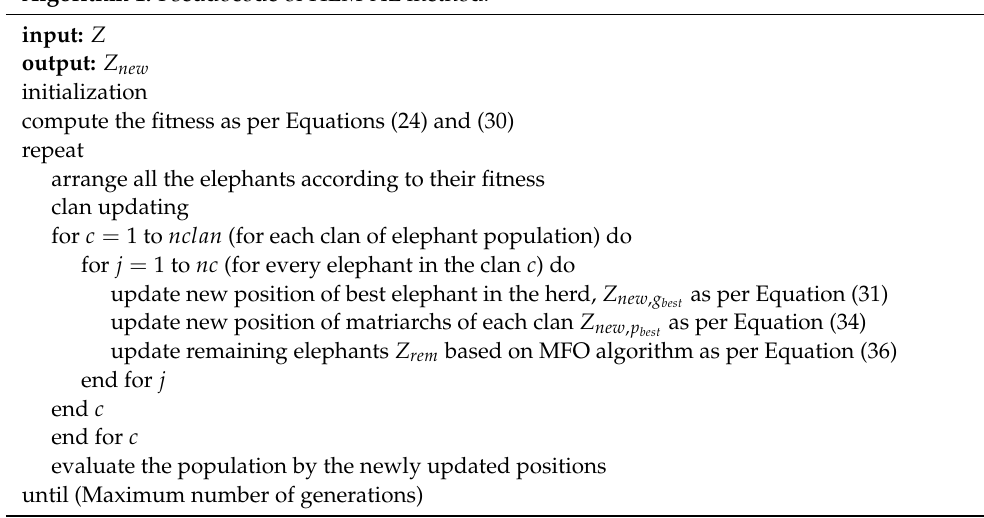
Algorithm 1: Pseudocode of HEM-AL